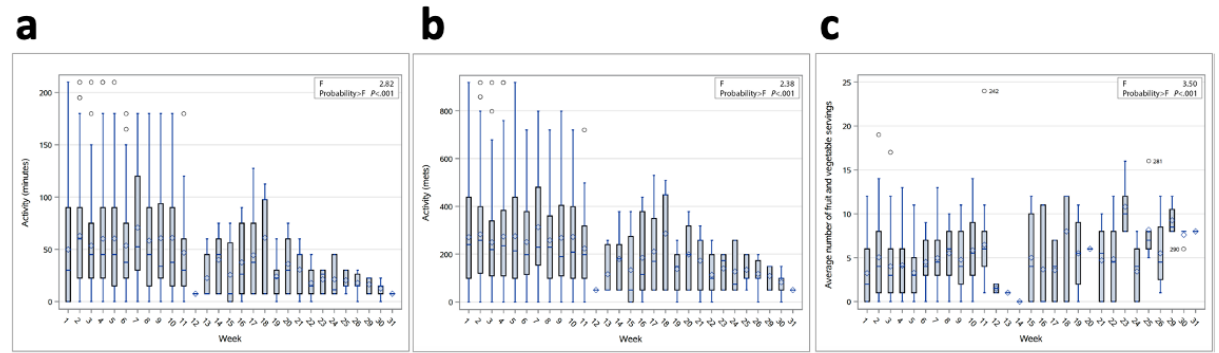
Figure 11. Analysis of variance of diary entries grouped per study week: (a) activity data (in minutes) over time; (b) activity data (in METS) over time; (c) fruit and vegetable servings over time. METS: metabolic